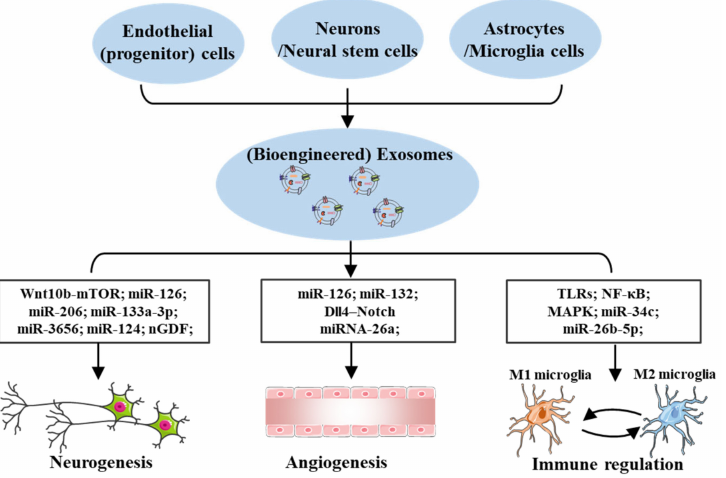
Figure 5. Exosomes-mediated effects in cerebral ischemia-reperfusion (I/R) injury. Exosomes derived from various cells in the central nervous system (CNS) play a pivotal role in neurogenesis and angiogenesis following I/R injury. In addition, the inhibition of M1 microglia polarization or the reprogramming of microglia from M1 to M2, mediated by exosomes, is important for the suppression of inflammation in cerebral I/R injury. Acronyms: Wnt10b, Wnt family member 10b; mTOR, mechanistic target of rapamycin; nGDF, nervous growth/differentiation factor; TLRs, toll-like receptors; NF- κ B, nuclear factor- κ B; MAPK, mitogen-activated protein